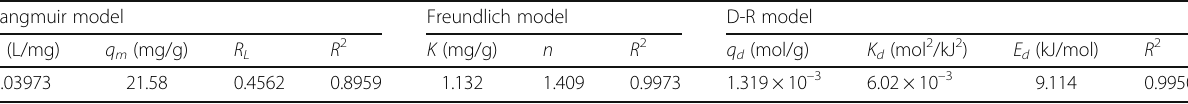
Table 2 The Langmuir, Freundlich, and D-R isotherm parameters for the adsorption of Cd 2+ by Fe 3 O 4 @PDA Langmuir model Freundlich model D-R